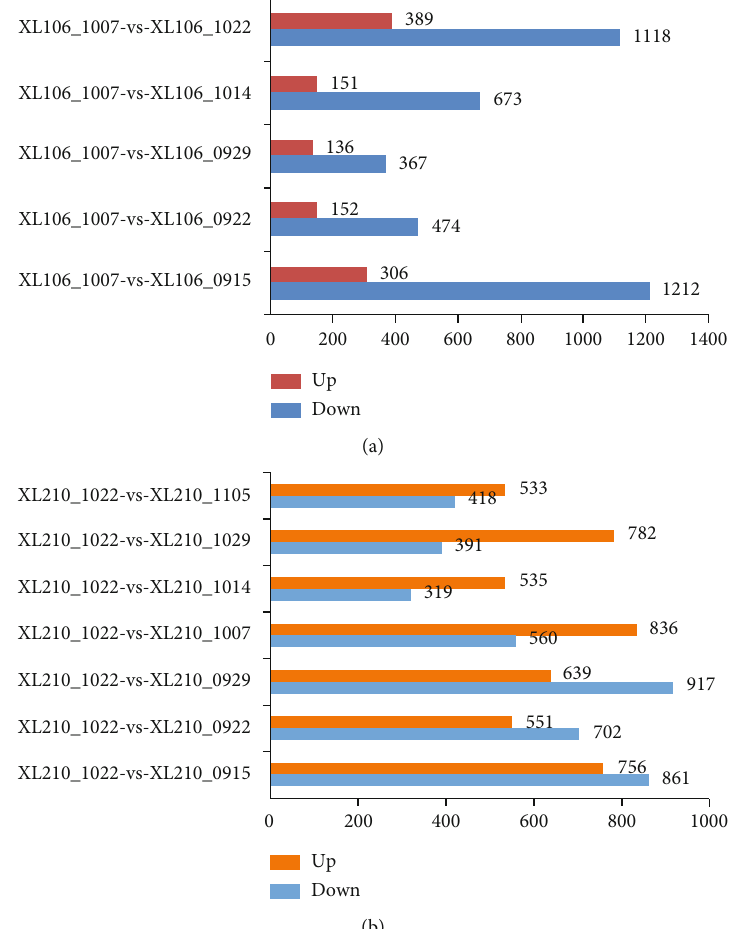
Figure 2: Analysis of the number of di ff erential genes at di ff erent time points. (a) Analysis of the number of di ff erential genes of XL106 at di ff erent time points. (b) Analysis of the number of di ff erential genes of XL210 at di ff erent time